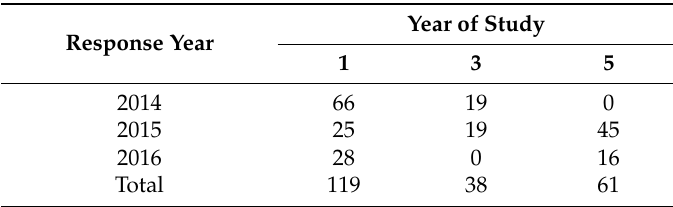
Table 1. Distribution of students replying to the survey (218 in total), according to year of study and response year.